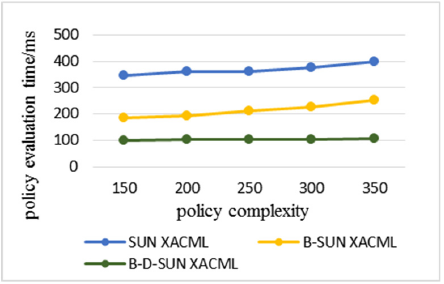
Figure 8. Policy evaluation time varies with the increasing complexity of the policy .